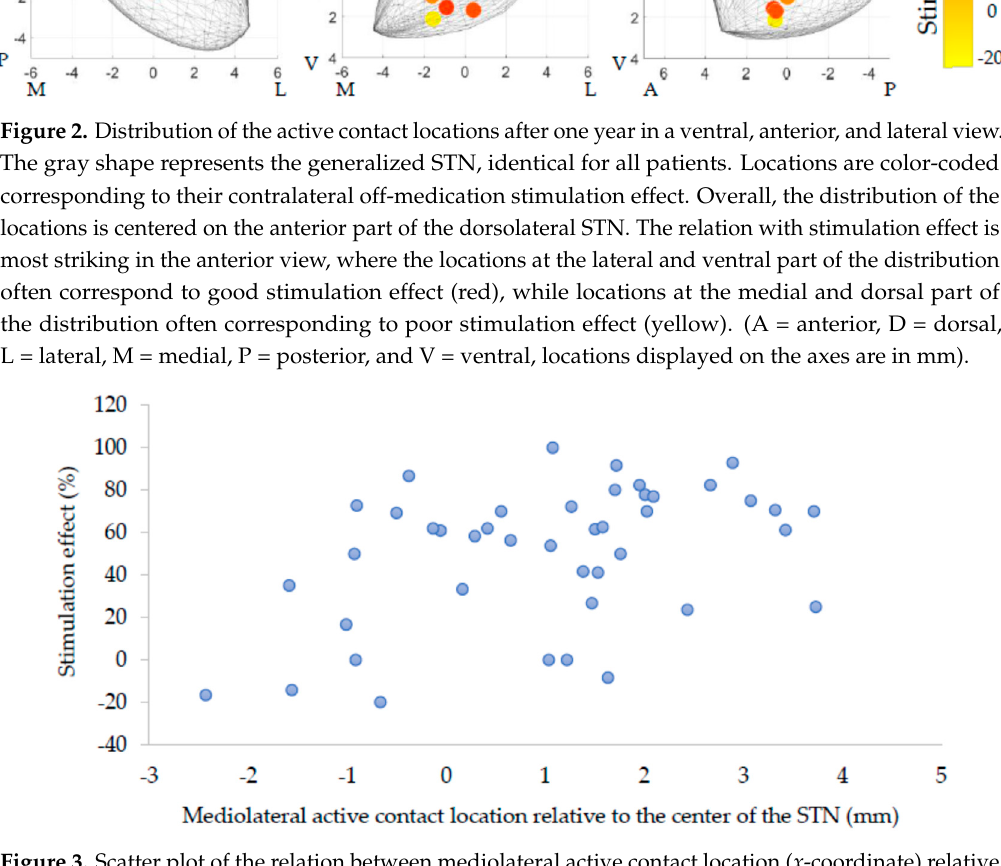
Figure 3. Scatter plot of the relation between mediolateral active contact location ( x -coordinate) relative to the center of the STN, and stimulation effect.